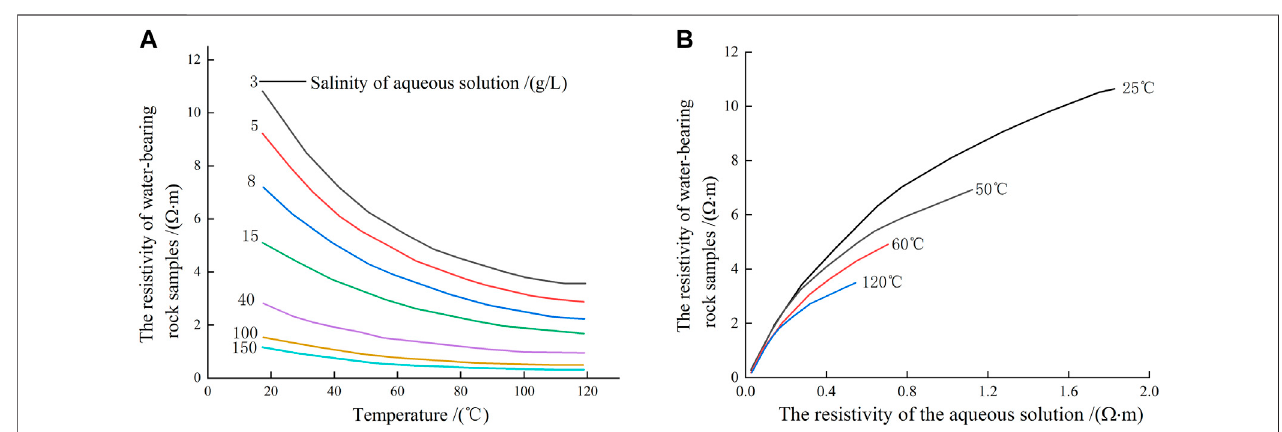
FIGURE 6 | Relationship curves of the resistivity of water-bearing rock samples, temperature, and the salinity of aqueous solution. (A) is the relationship curves of temperatureandresistivityofwater-bearingrocksampleunderdifferentsalinityofaqueoussolution. (B) istherelationshipcurvesoftheresistivityofaqueoussolutionand the resistivity of water-bearing rock samples at different temperatures.